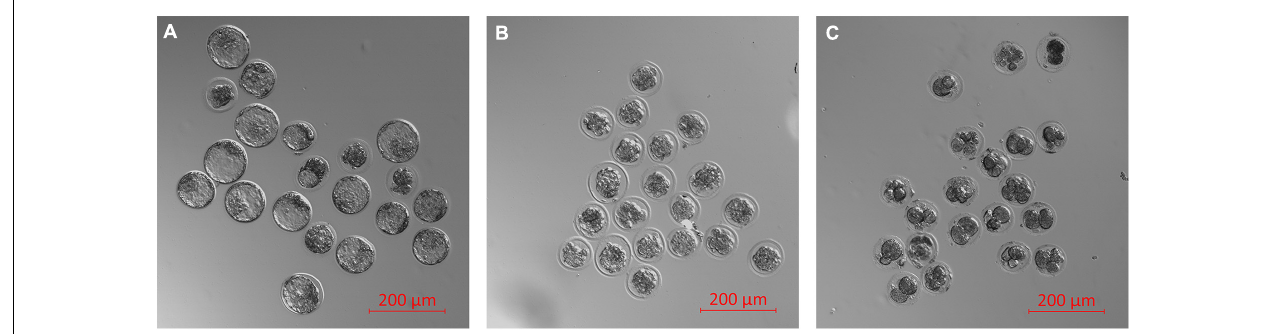
FIGURE 6 | Representative micrographs of vehicle-treated, rhein-treated, and degenerate embryos. Three groups of embryos consisting of (1) vehicle-treated (0.5% DMSO) late morulae and early blastocysts from 99 to 116 h post-hCG (A) , (2) rhein-treated (120 µ M) late morulae and early blastocysts from 99 to 116 h post-hCG